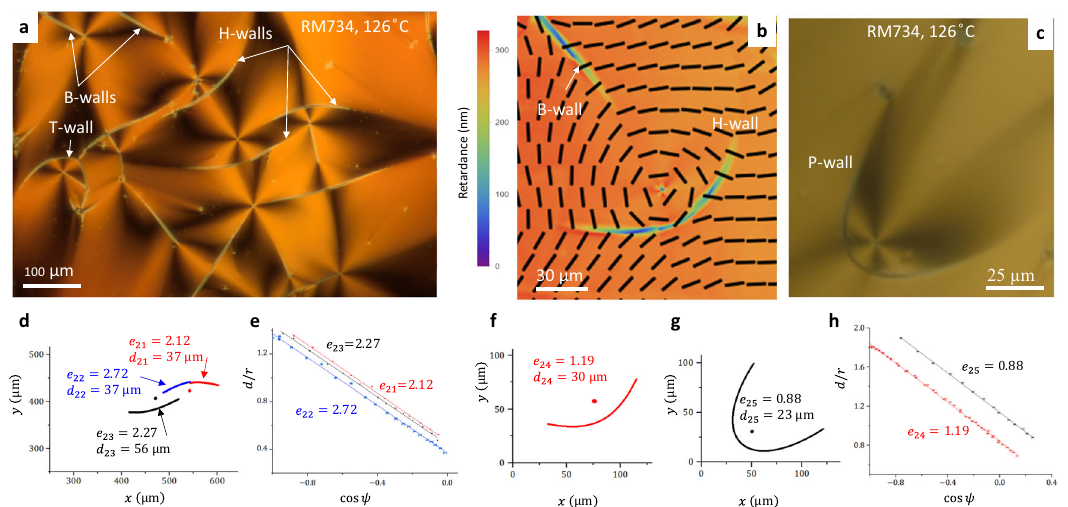
Fig. 2 | Hyperbolic domain walls in N F fi lms of DIO. a Polarizing microscopy texture of two H-walls with T-walls and circular C-walls at their tips; h ≈ 6 μ m; labeled by arrows are also three B-walls associated with a +1 circular vortex in the right-hand part ofthe texture. b The corresponding eccentricities ofthe H-walls in ( a ). c PolarizingmicroscopytextureoftwoH-wall,oneofwhichfeaturesa − 1defect atthevertexwithnoT-wall; h ≈ 6 μ m;aB-wallextendsfromthefaintcircularC-wall